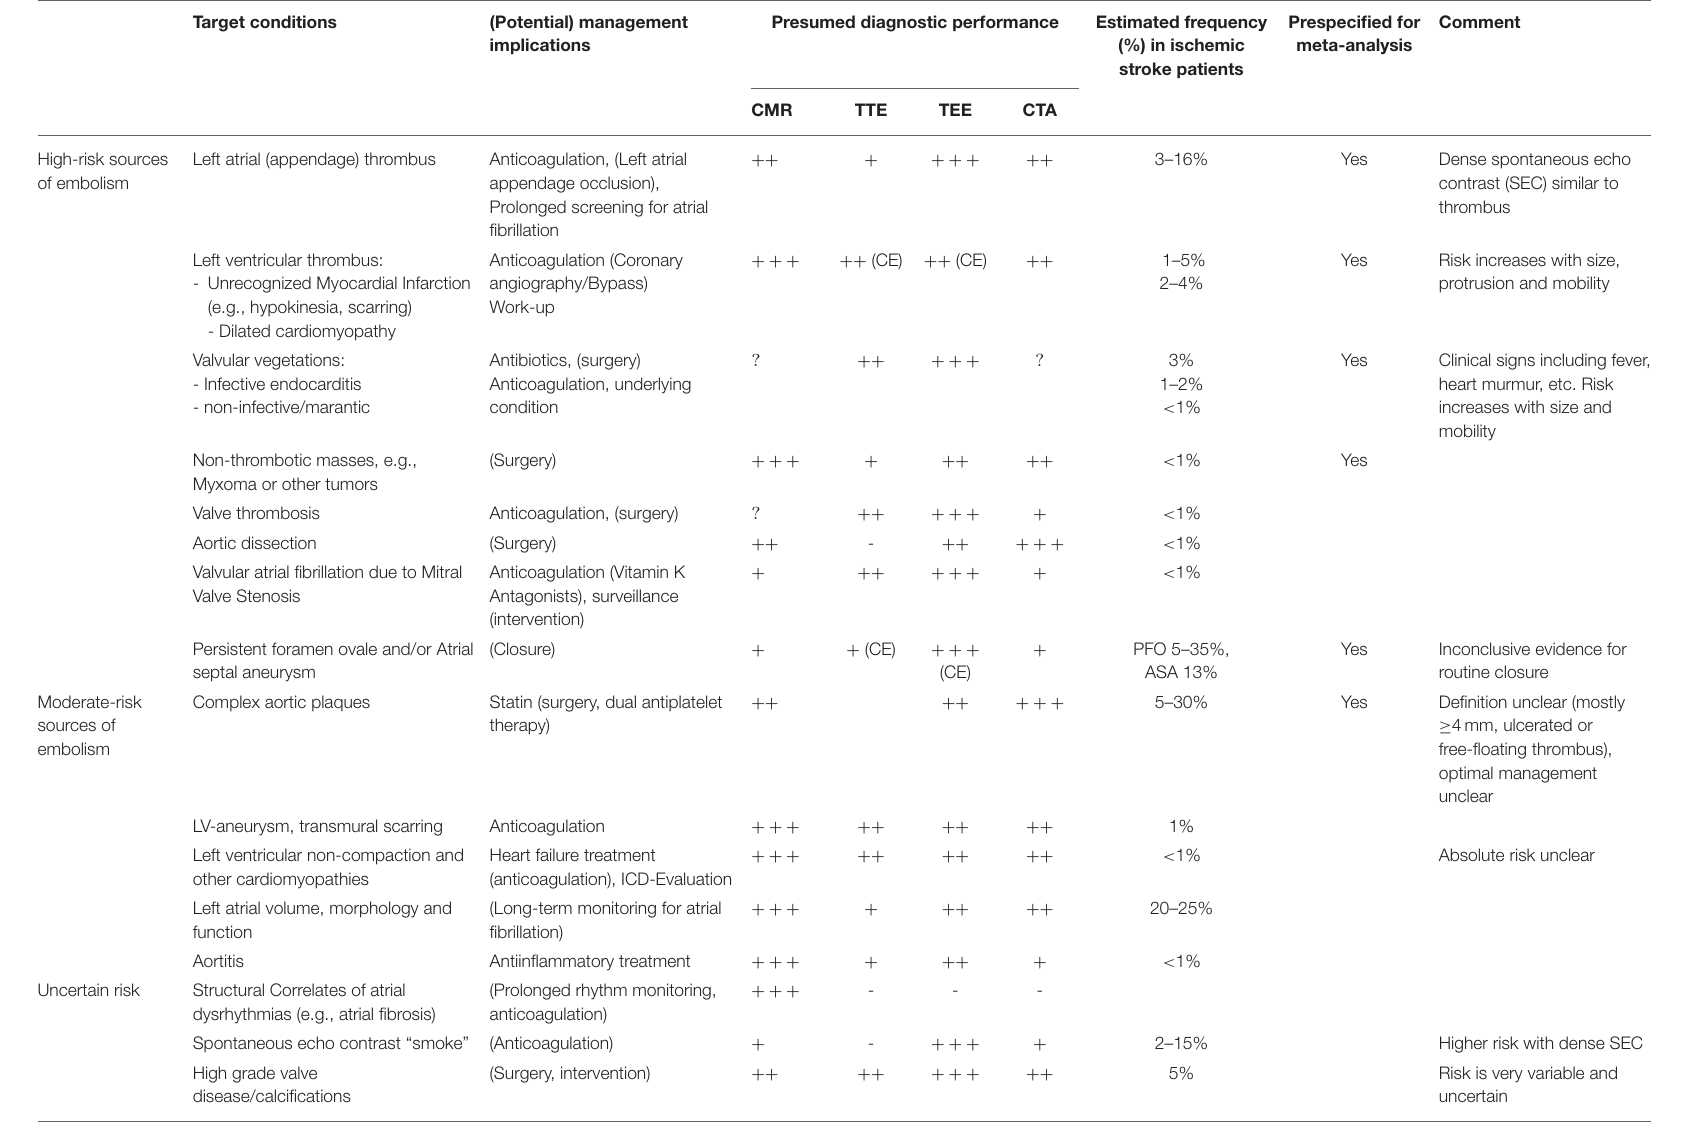
TABLE 1 | Cardioaortic sources of embolism, management implications, and diagnostic